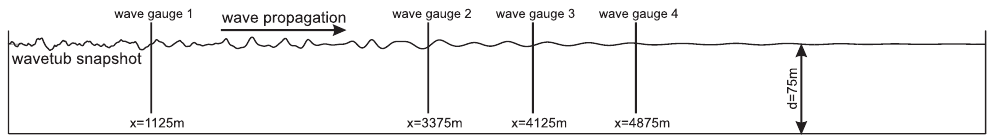
Figure 5. Scheme of the semi-experimental procedure including validation locations—all data full scale